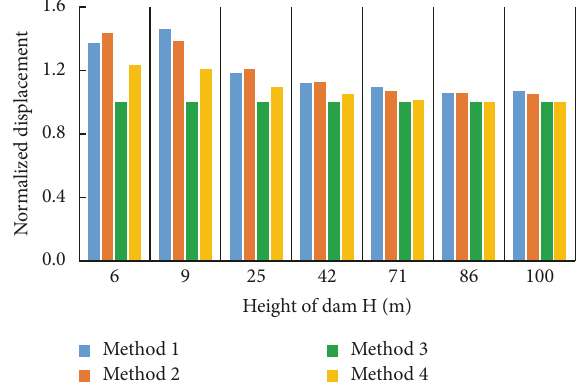
Figure 20: Timehistorycurve ofthe X component relative displace- ment at the top of dam.